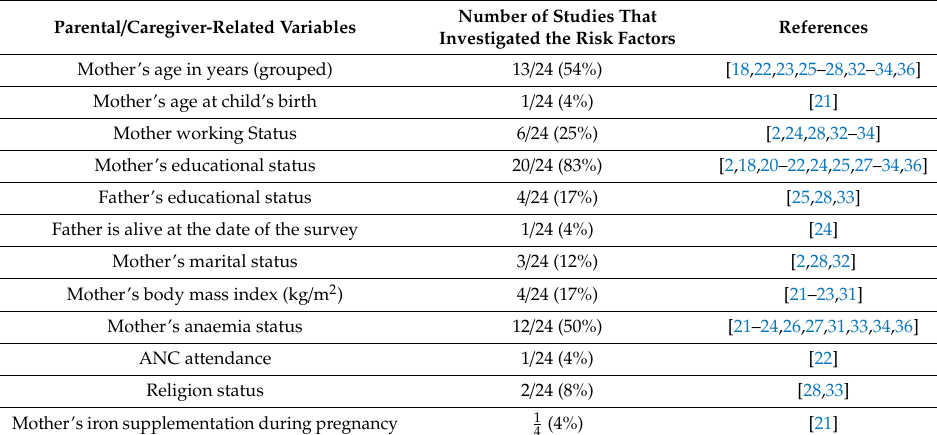
Table 6. Distribution of the study characteristics of the parental / caregiver-related variables for anaemia.